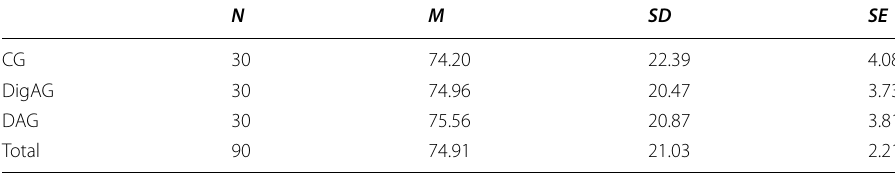
Table 16 Descriptive statistics of anxiety pretest of all groups N